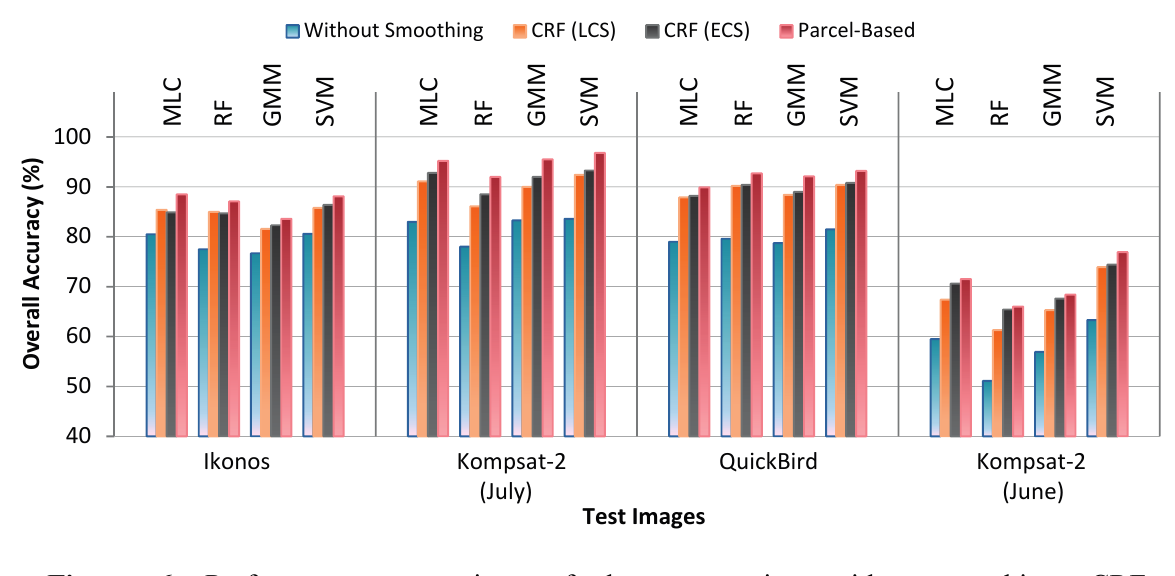
Figure 6. Performance comparison of three strategies, without-smoothing, CRF smoothing, and parcel-based